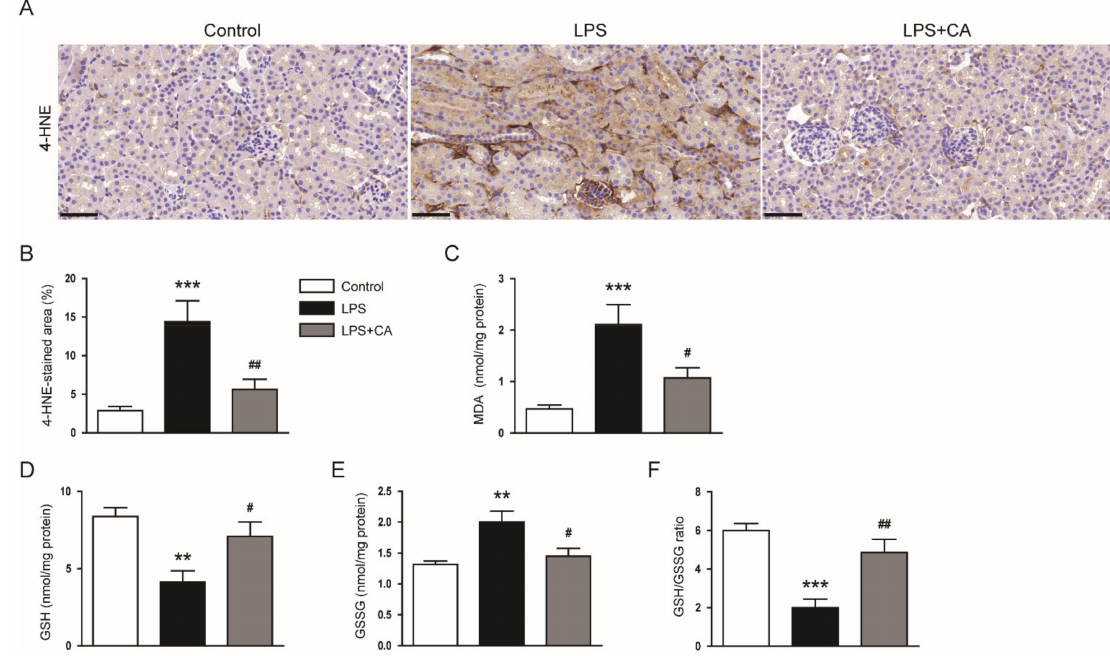
Figure 6. Effect of carnosic acid on oxidative stress. ( A ) IHC staining for 4-HNE. Scale bar = 50 µ m. ( B ) Percentage of 4-HNE-stained area. ( C ) Renal MDA levels. n = 8 per group of mice. ( D ) Renal GSH levels. ( E ) Renal GSSG levels. ( F ) GSH/GSSG ratios. ** p < 0.01 and *** p < 0.001 versus control. # p < 0.05 and ## p < 0.01 versus